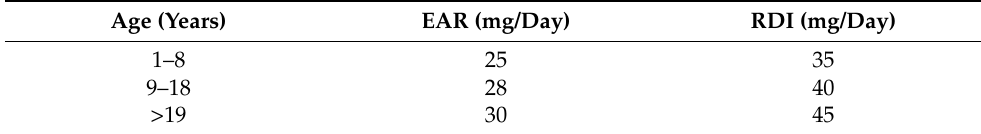
Table 1. Recommended Daily Requirements for Vitamin C in Australia